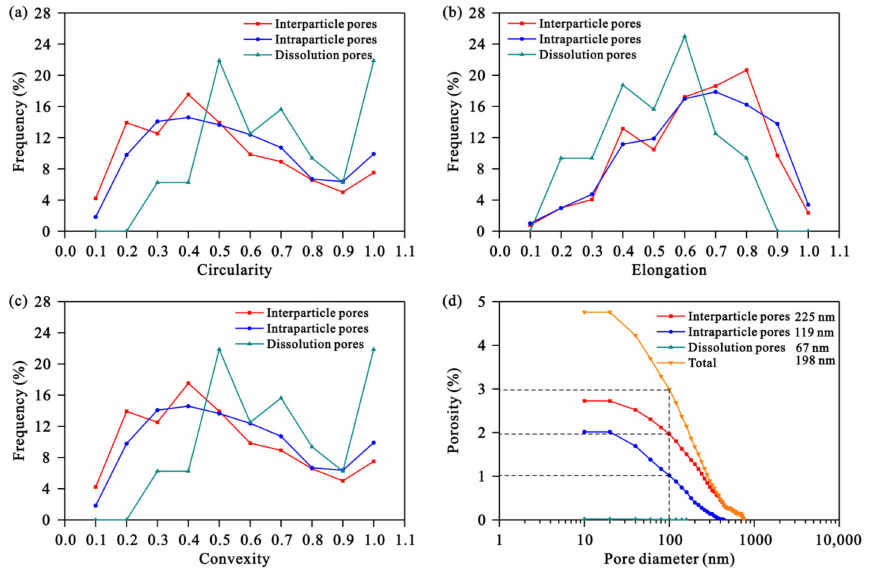
Figure 4. Pore morphology parameters and pore size distributions in argillaceous shales: ( a ) Circularity; ( b ) Elongation; ( c ) Convexity; ( d ) Pore size